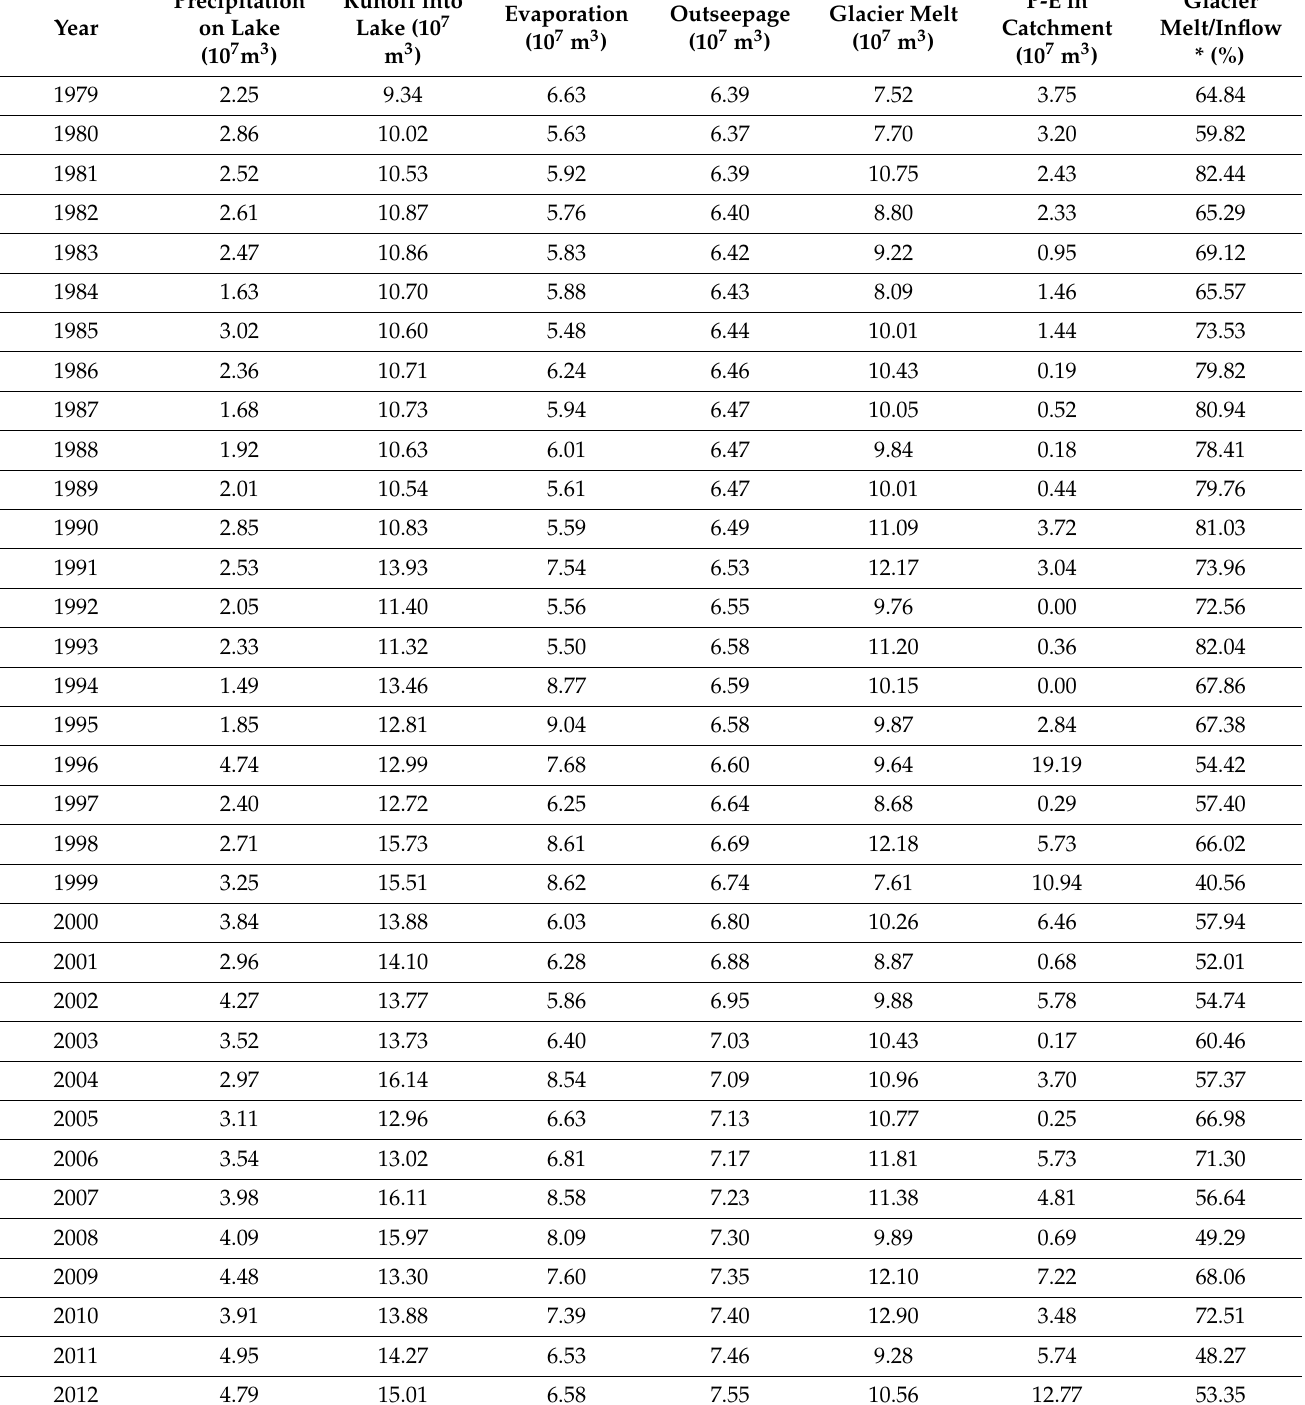
Table 2. Simulated annual amount of each flux of Linggo